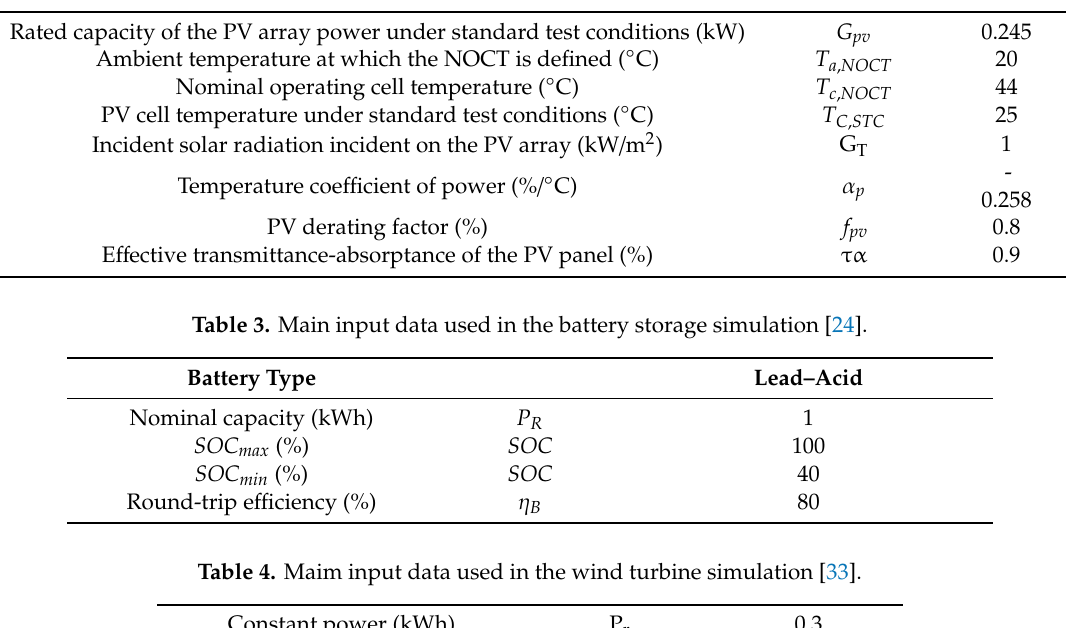
Table 2. Main input data used in the solar panel simulation [32].